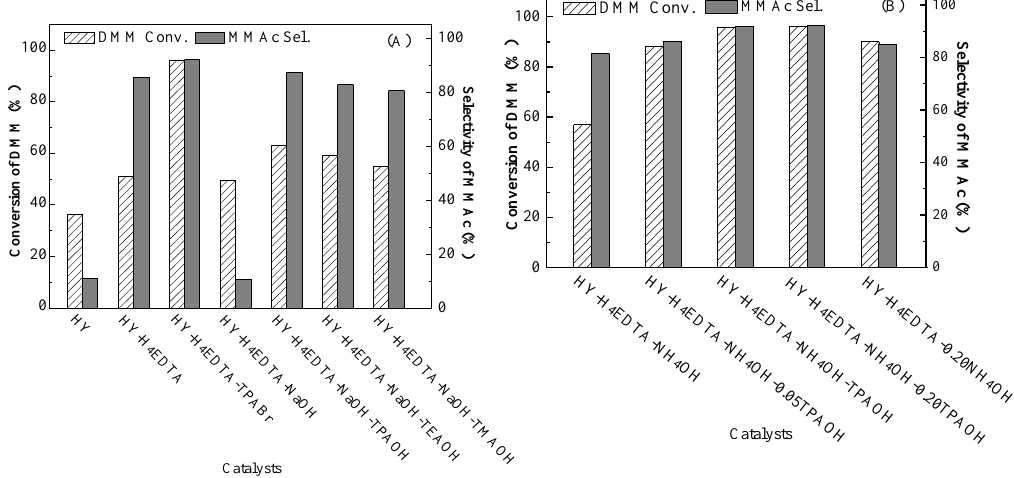
Figure 7 . The effect of different catalysts ( A ) and ( B ) on the carbonylation of dimethoxymethane (DMM) to methyl methoxyacetate (MMAc). Reaction conditions: catalyst weight, 1.0 g; reaction temperature, 100 °C; reaction pressure, 5.0 MPa; total CO flow rate, 100 mL/min; time on stream, 2 h.